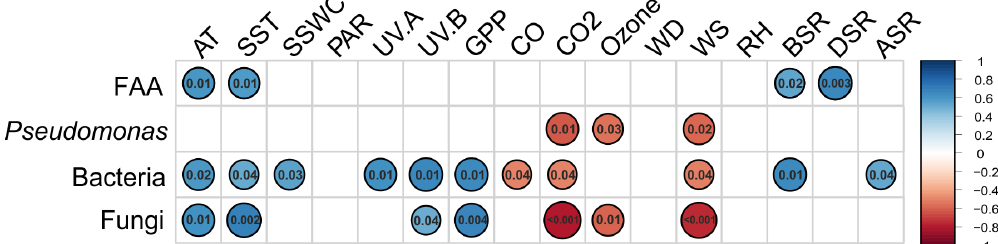
Figure 4. Summary of Spearman correlation results (total particles). The colour scale indicates positive/negative correlation ( p values are shown). Abbreviations: AT, air temperature; SST, soil surface temperature; SSWC, soil surface water content; WS, wind speed; WD, wind direction; GPP, gross primary production; Ozone, ozone concentration; PAR, photosynthetically active radiation; RH, relative humidity; BSR, rainfall 72h before sampling; DSR, rainfall during sampling; ASR, rainfall 168h after